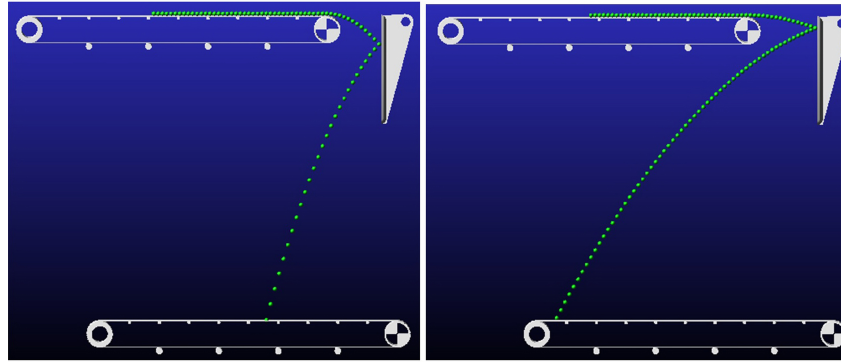
Figure 11. Trajectory of the material particle’s movement at v 1 = 2ms − 1 (left), v 1 = 4ms − 1 (right). Table 2. Parameters of the re-direction model in the workbench of the program ADAMS. Parameters of re-direction